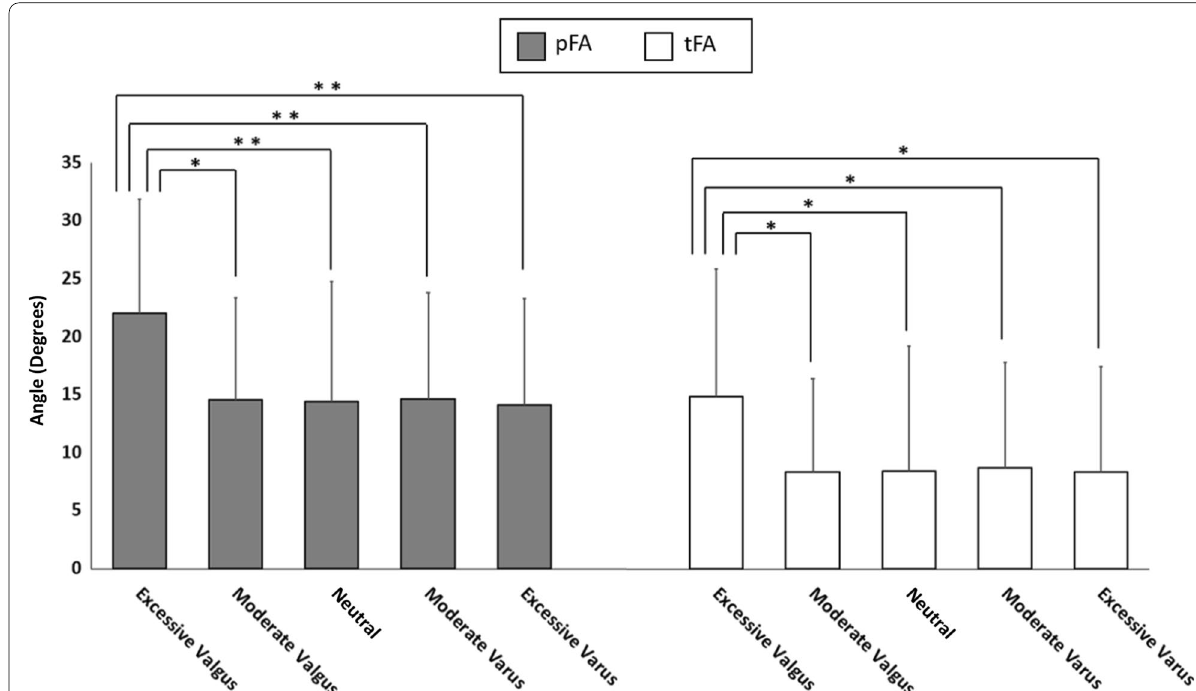
Fig. 5 Comparison of radiographic parameters between the groups divided by mechanical tibiofemoral axis. Both pFA and tFA were increased in the excessive valgus group compared to all other groups. * p < 0.05; ** p < 0.01